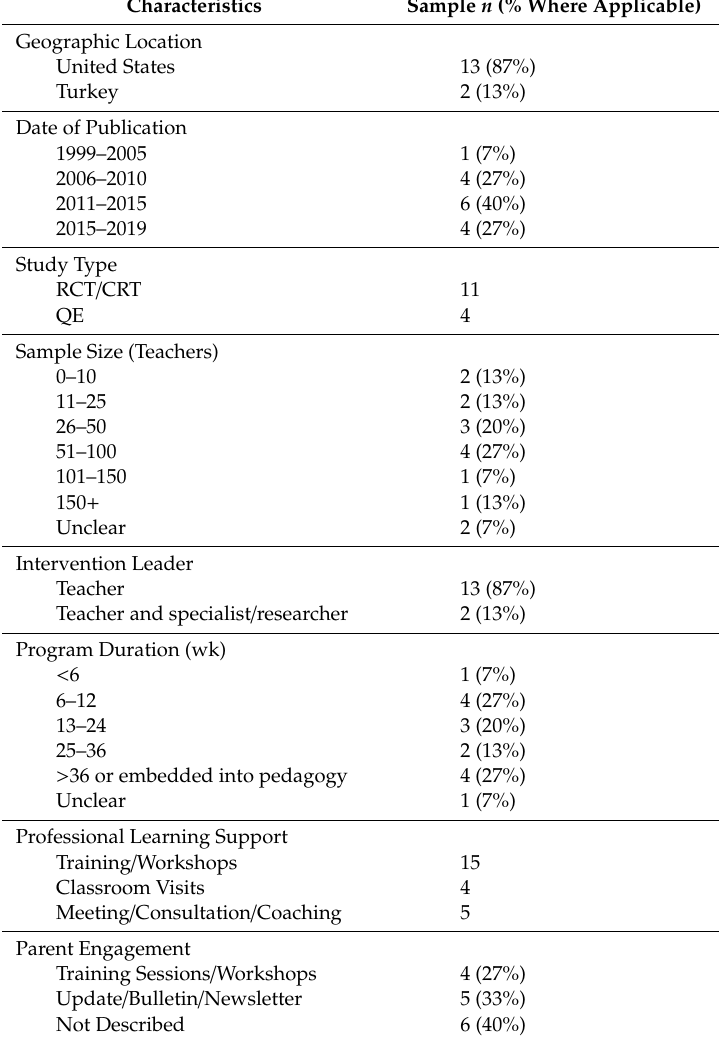
Table 3. Pooled Summary of the 15 Studies Investigating the E ff ect of Universal Curriculum-Based SEL Programs on Teacher-Level